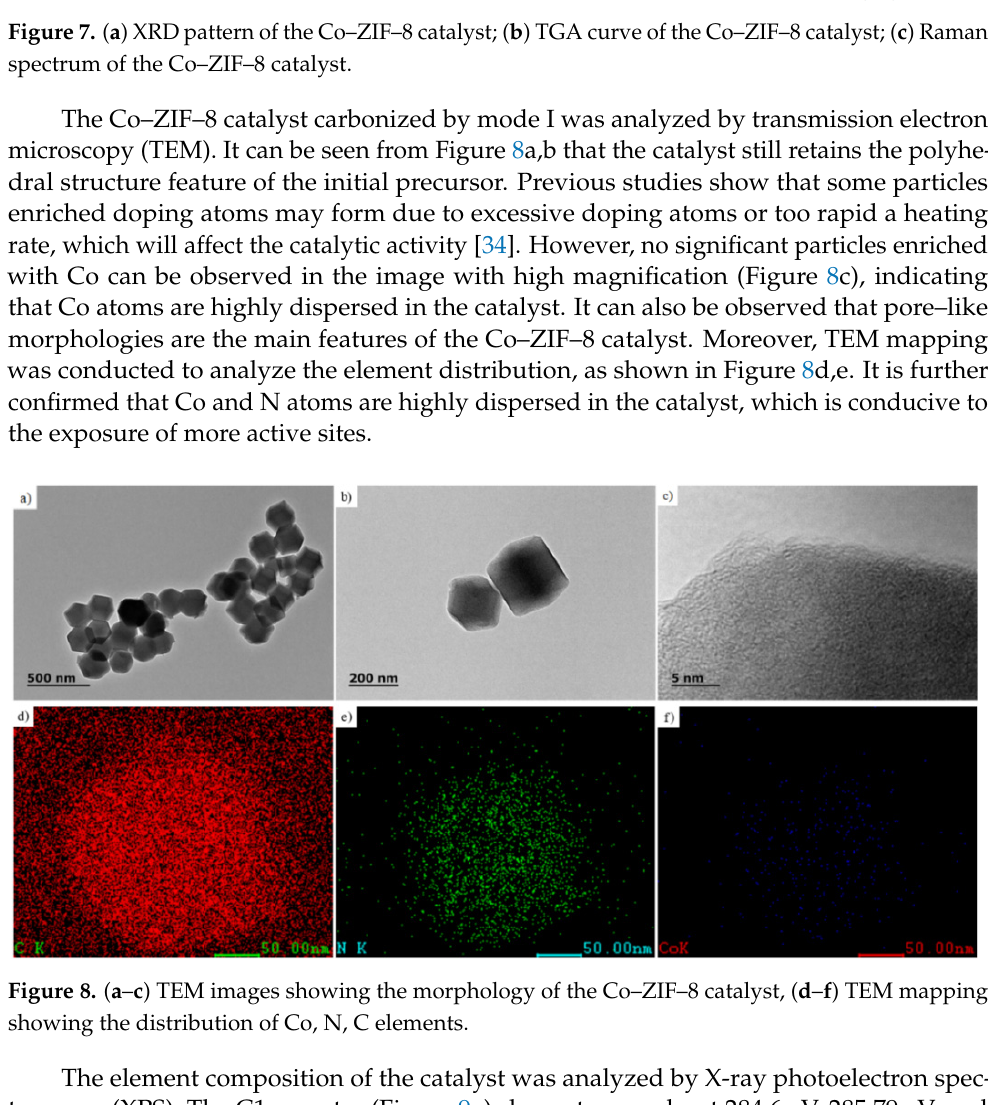
Figure 9. XPS spectra of the catalyst carbonized at the optimum pyrolysis condition ( a ) C1s, ( b ) N1s, ( c ) Co 2p.